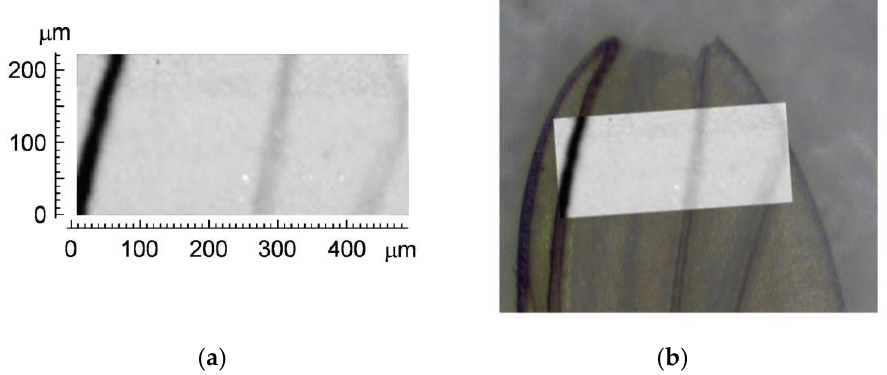
Figure 15. ( a ) Scanning transmission ion microscopy (STIM) image (100 × 47 pixel) of a part of a mosquito wing; ( b ) raster image is overlaid on photograph of the wing. (Reprinted from [45], Copyright (2012), with permission from Elsevier).